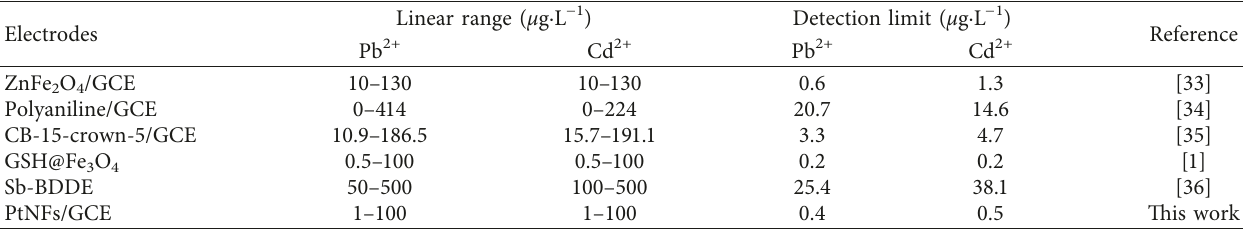
Table 1: Comparison of the proposed sensor with other reported